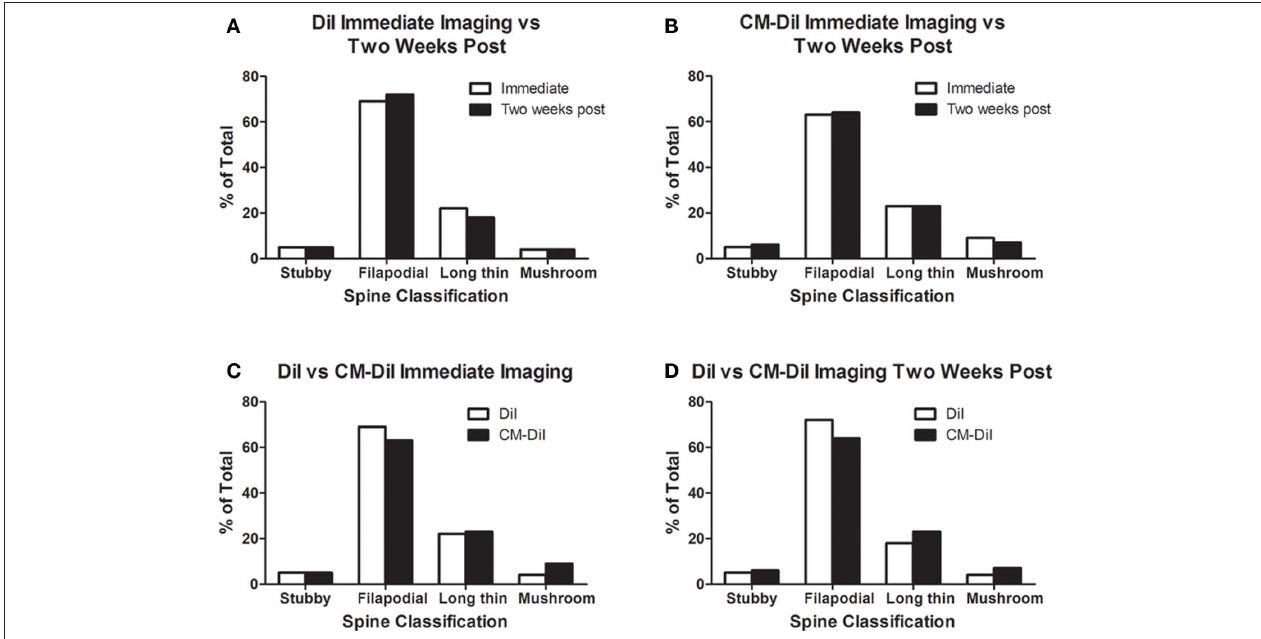
Figure 4 | Spine morphology analysis of Dii and CM-Dii treated tissues. (A,B) No significant differences in spine morphology were observed in DiI or CM-DiI treated tissues of non-permeabilized tissues between images captured immediately or 2 weeks following mounting. (C,D) No significant differences in spine morphology were observed between DiI and CM-DiI treated tissues of non-permeabilized tissues imaged either immediately or 2 weeks following tissue